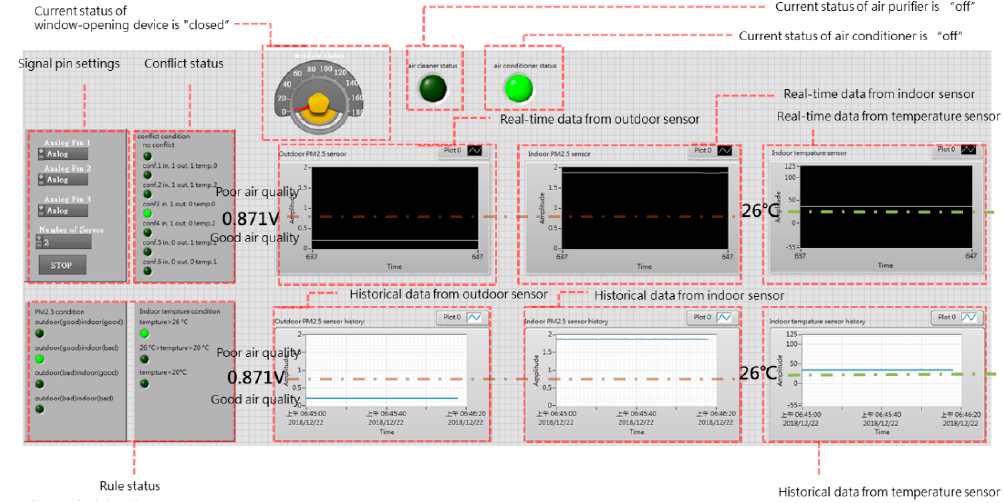
Figure 18. Explanation of user interface.